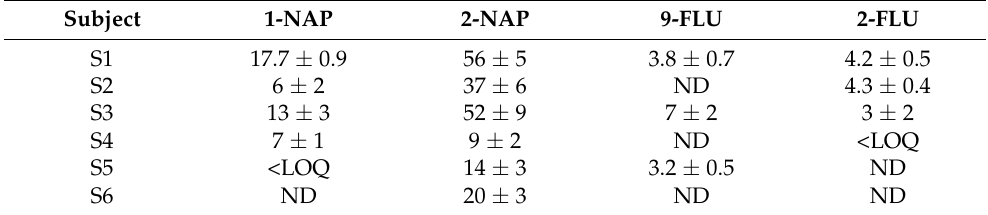
Table 7. Found concentrations in µ g L − 1 of four of the six OH-PAHs in six urine samples collected from exposed (S1, S2, and S3) and non-exposed volunteers (S4, S5, and S6). 1-ACE and 9-PHE were found below of detection limits of the method in all